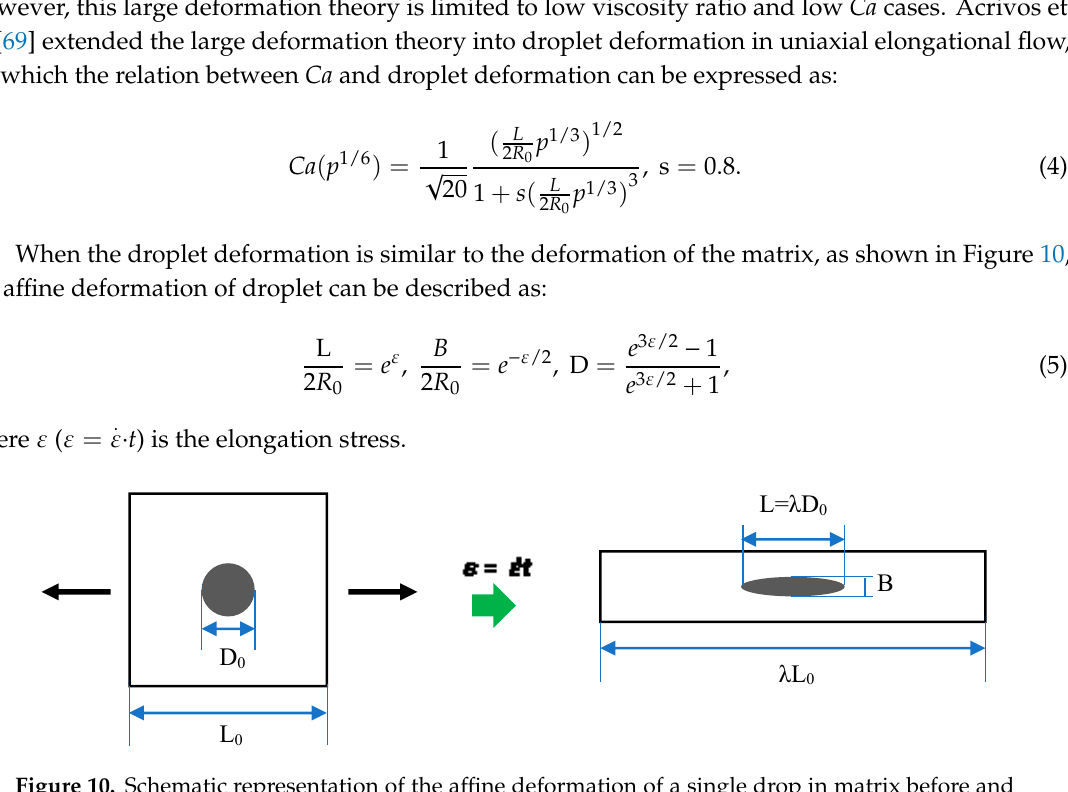
Figure 10. Schematic representation of the affine deformation of a single drop in matrix before and after deformation. L 0 and λ L 0 are the initial and final lengths of the specimen, respectively. D 0 is the initial drop diameter and λ D 0 is the major axis of the elongated droplet.